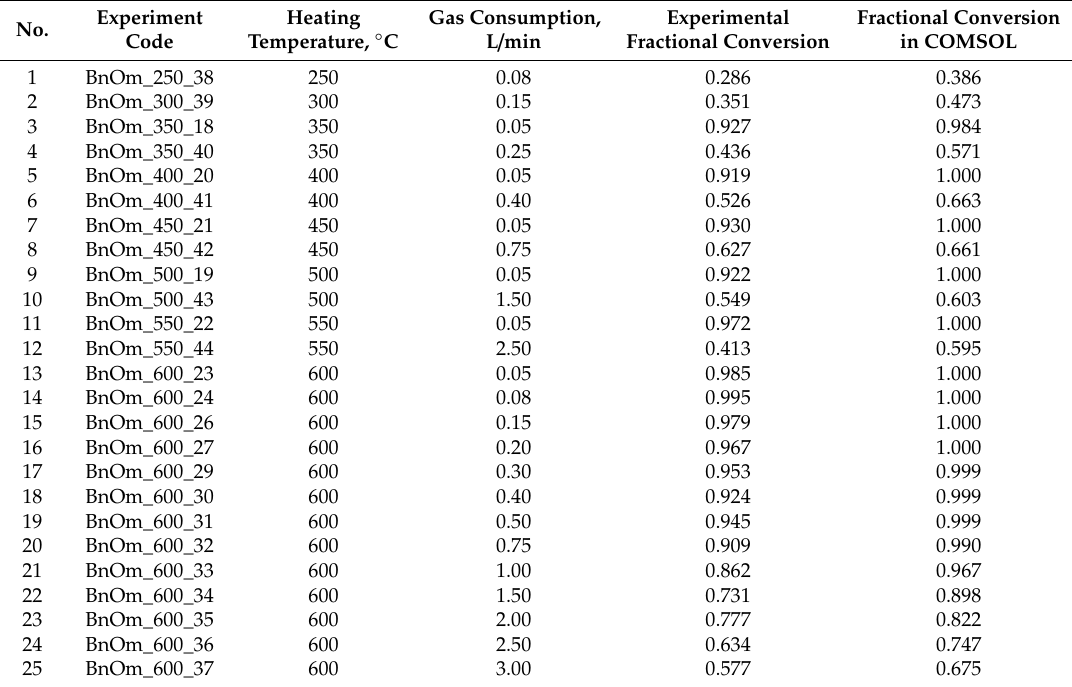
Table 9. Comparison of the experimental fractional conversion of O-methyl N-benzyl carbamate with the data of the calculation experiments.